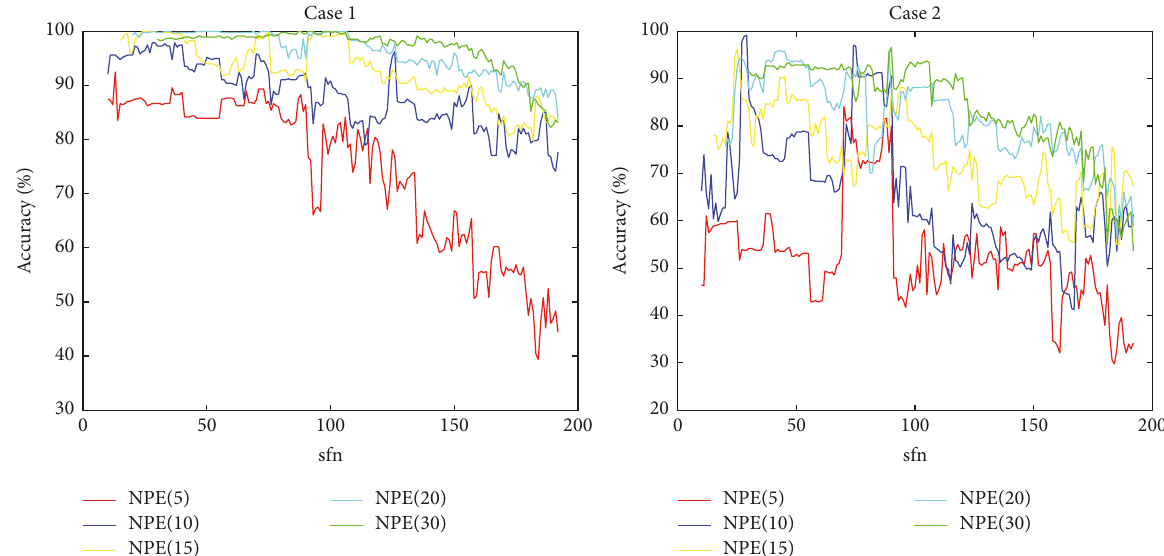
Figure 15: The diagnosis results obtained by OFS-FSASD-NPE-SVM model using WPT with different dimension sizes for NPE. The NPE (5) represents that the number of dimension sizes is 5.